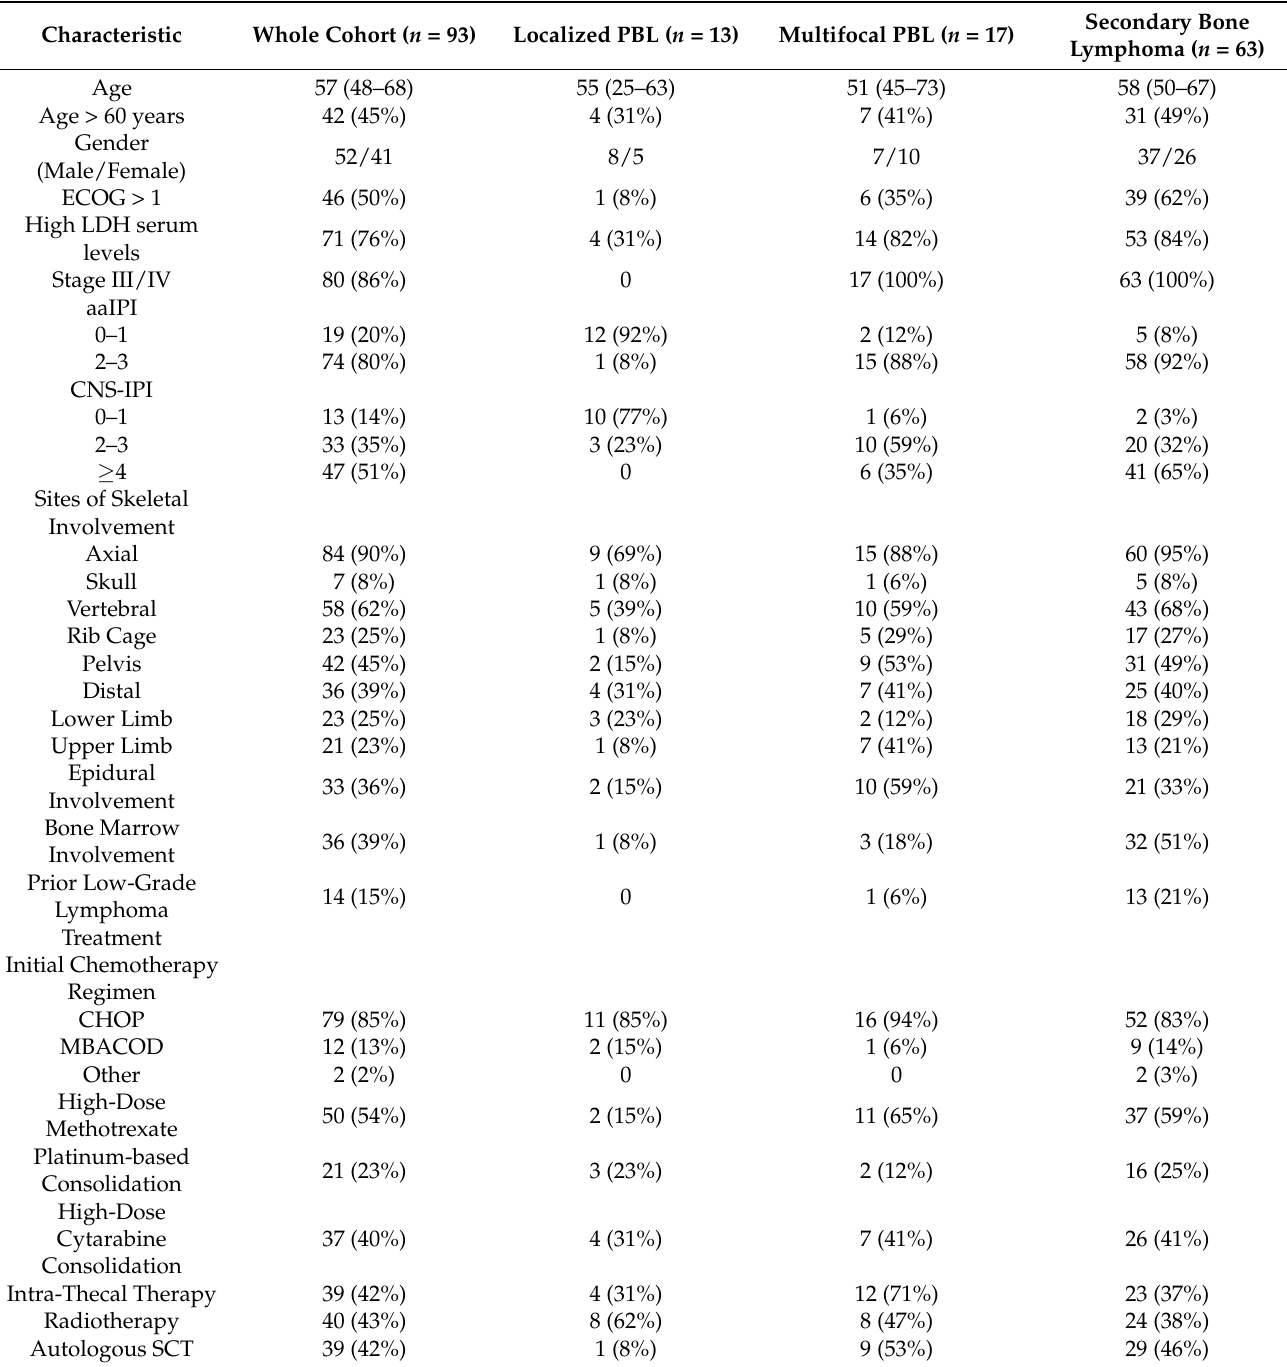
Table 1. Characteristics of the whole cohort and of patients with localized and multifocal primary bone lymphoma and secondary bone